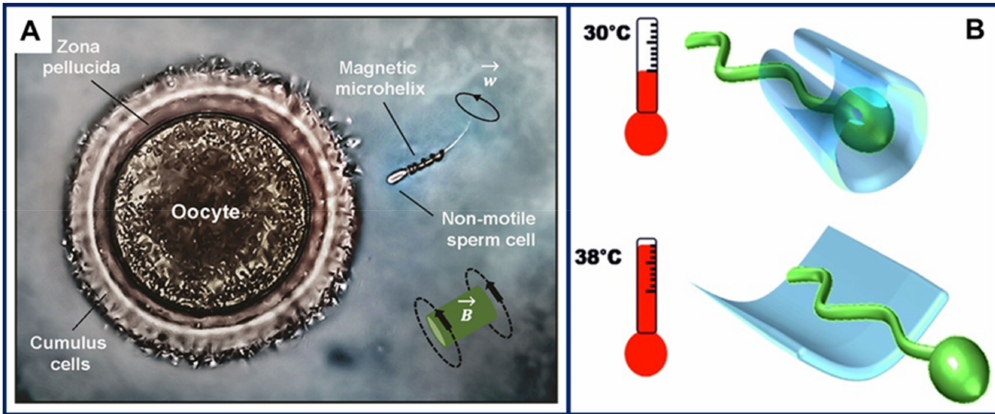
Figure 6. Spermbots for assisted fertilization. ( A ) An immotile sperm cell is captured by a remotely controlled magnetic helix and delivered to the oocyte for fertilization. Figure reproduced from [1], © 2015 American Chemical Society. ( B ) Thin thermoresponsive ferromagnetic multilayers roll into microtubes to help capture sperm cells and remotely control them by external magnetic fields. The polymeric spermbots are propelled by the sperm flagella. When the temperature is increased, the microtubes unfold and the sperm cell is released. Figure reproduced from [94], © 2016 WILEY-VCH Verlag GmbH &